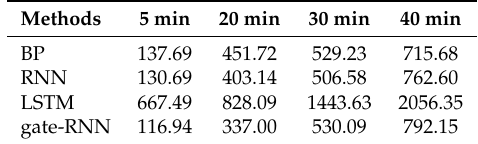
Table 7. Results of the RMSE for different time scales.